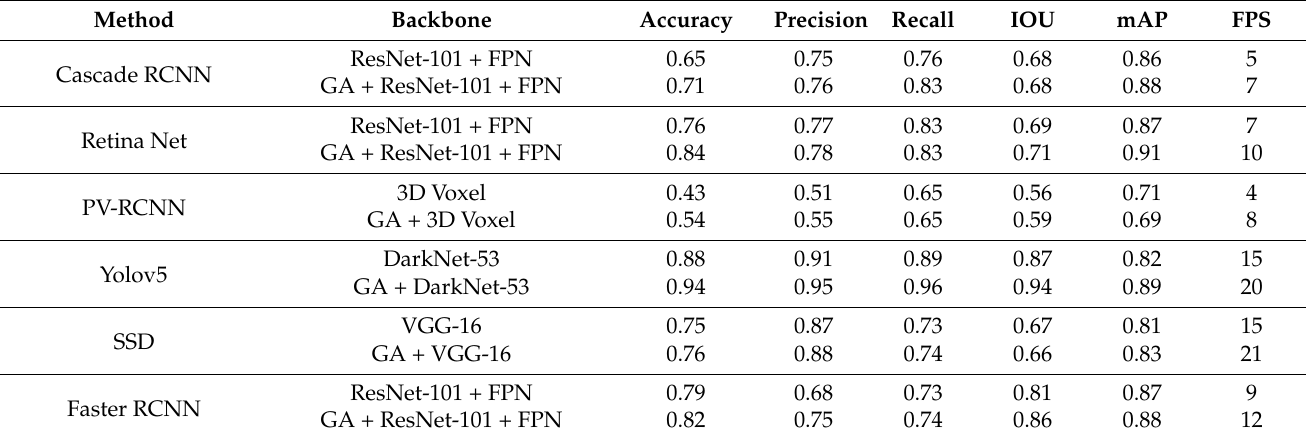
Table 2. Comparison of six different detection